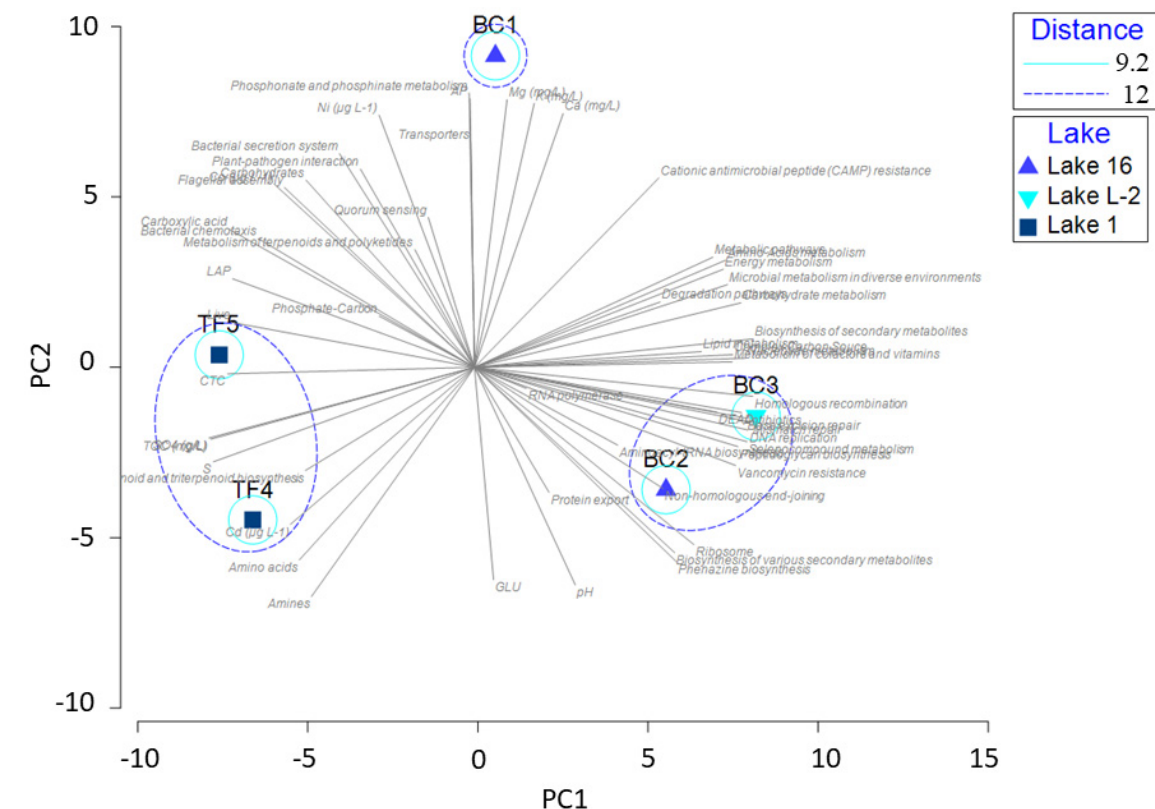
Figure 7. Principal component analysis computed on the entire dataset, including results from enzymatic activities, physicochemical parameters, microbiological data, archaeal and bacterial community composition, and predictive analysis of the metabolic pathways of brine samples.